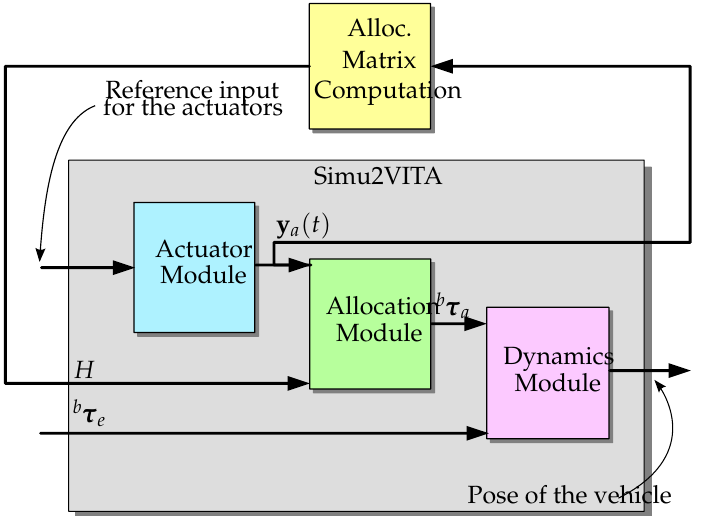
Figure 7. The logic representation of an external calculator for the allocation matrix in case of a moving